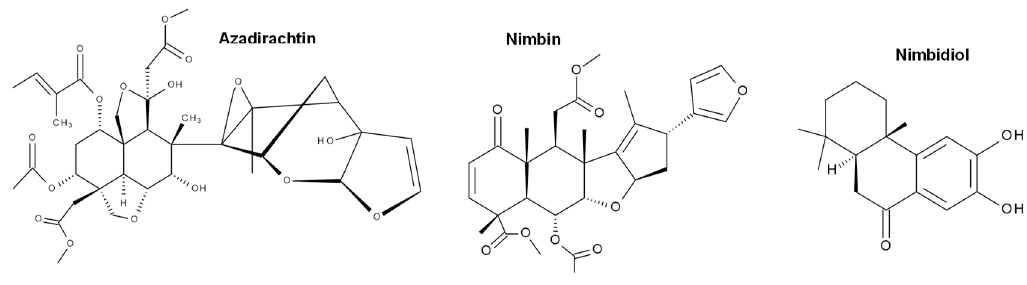
Figure 12. Chemical structure of some of the main components of Azadirachta indica extract.